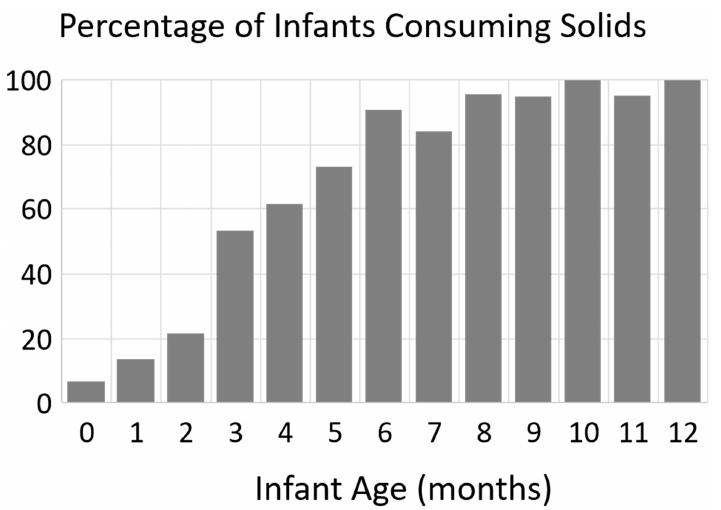
Figure 2. Presented are the percentage of infants that reported consuming any solid foods on any of the days when 24 h dietary recall was administered, by infant age in months.